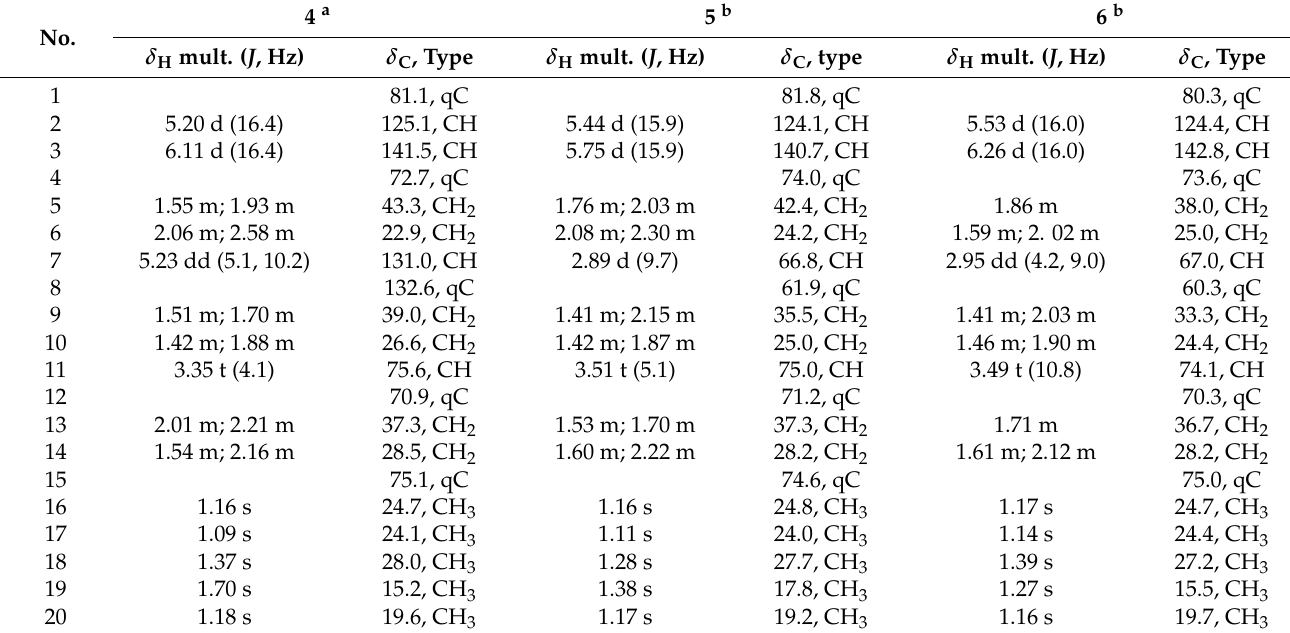
Table 2. 1 H NMR and 13 C NMR data for compounds 4–6 .